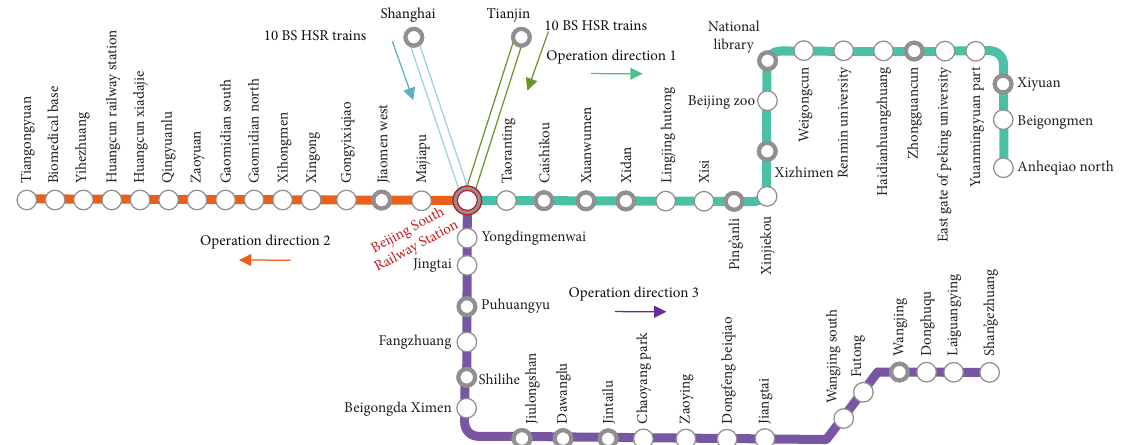
Figure 5: Network used in the numerical